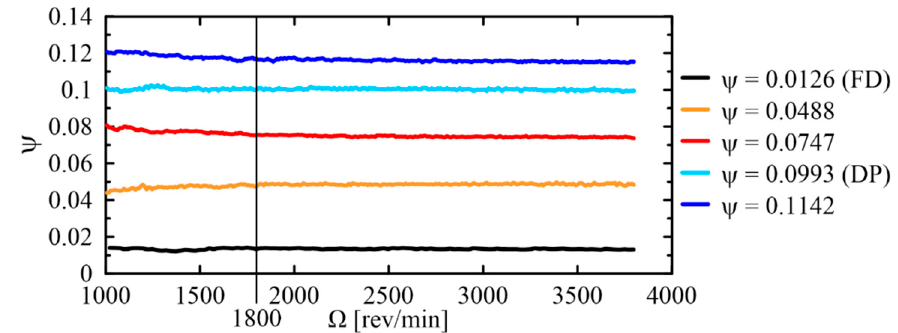
Ψ trend during di ff erent Ω ramps.